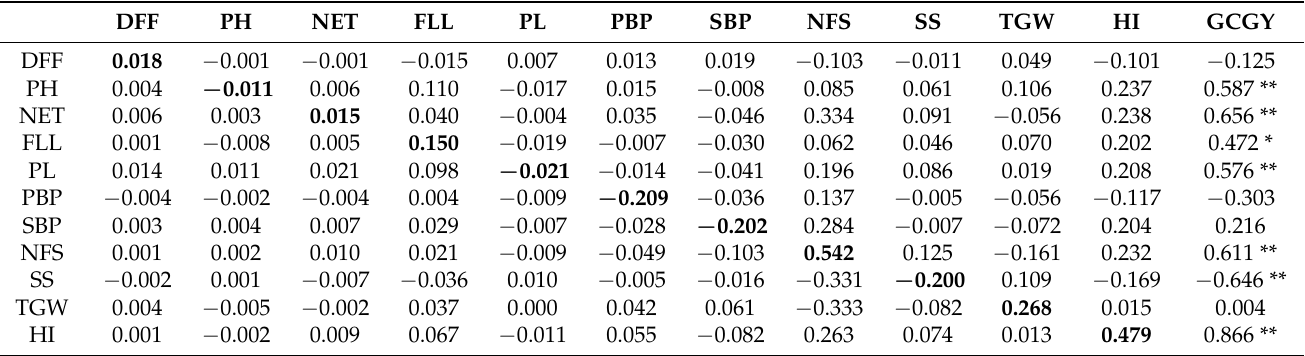
Table 5. Partitioning of genotypic correlation with GY into direct (bold) and indirect PCs in 20 genotypes of T. Aman